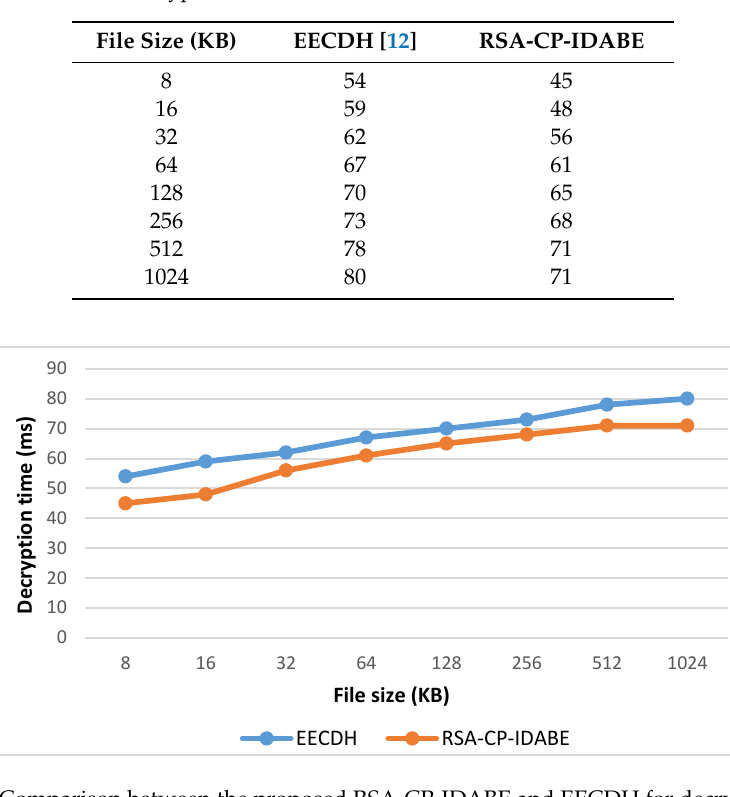
Table 3. Decryption time vs. file size for RSA-CP-IDABE & EECDH.